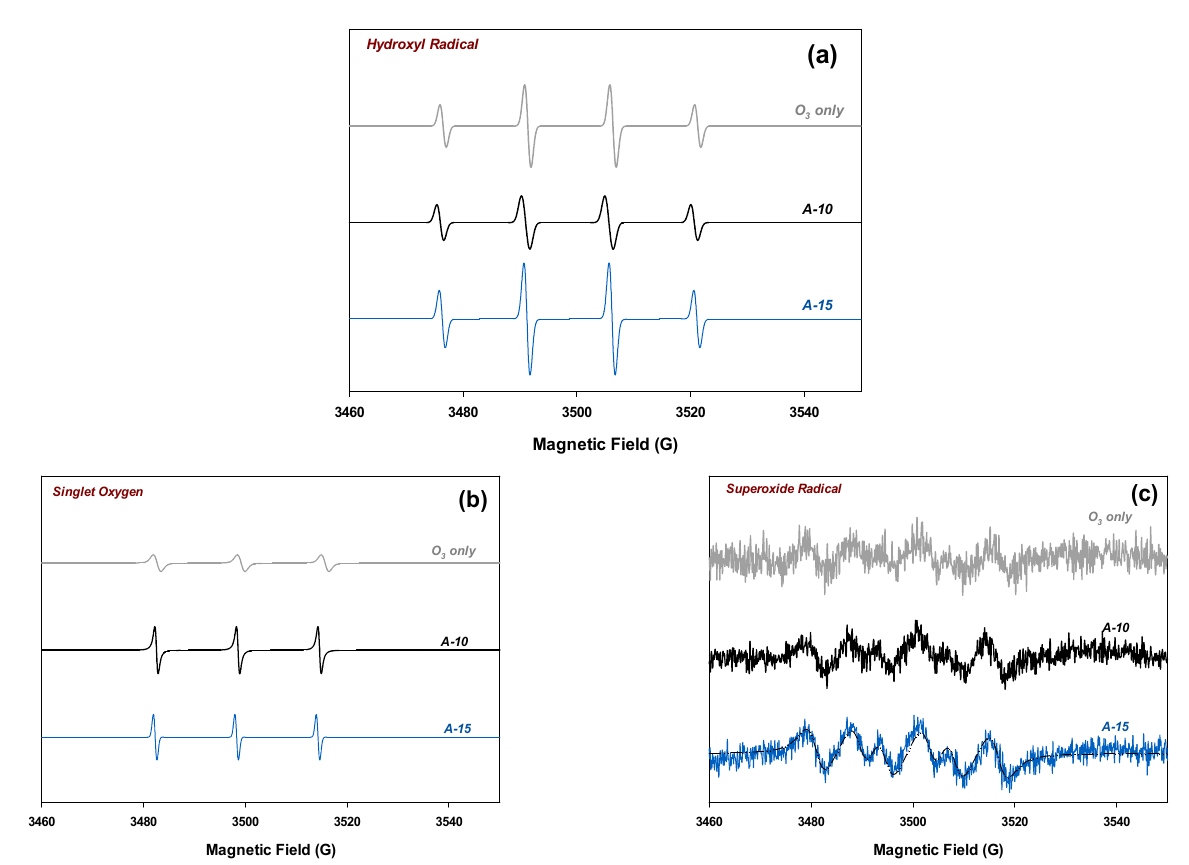
Figure 8. EPR spectra using ( a ) DMPO as hydroxyl radical trapping agent in water, ( b ) TEMP as singlet oxygen trapping agent in water, and ( c ) DMPO as superoxide radical trapping agent in absolute ethanol.